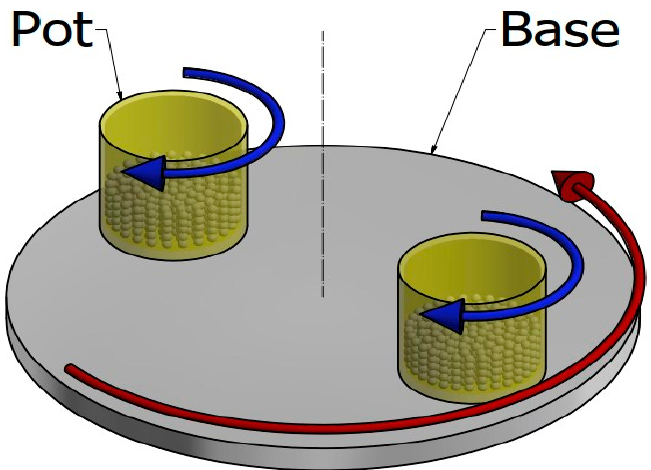
Figure 1. Schematic diagram of the planetary ball mill.